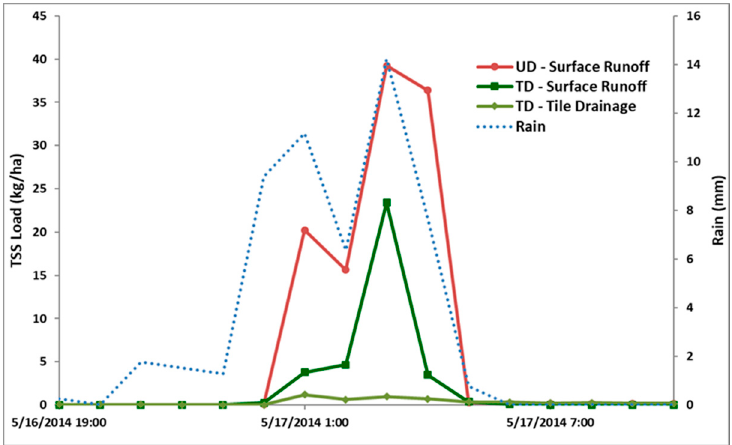
Figure 5. Total suspended solids (TSS) loading by hydrologic pathway from tile-drained (TD) and undrained (UD) plots during the 16 May 2014 runoff event.